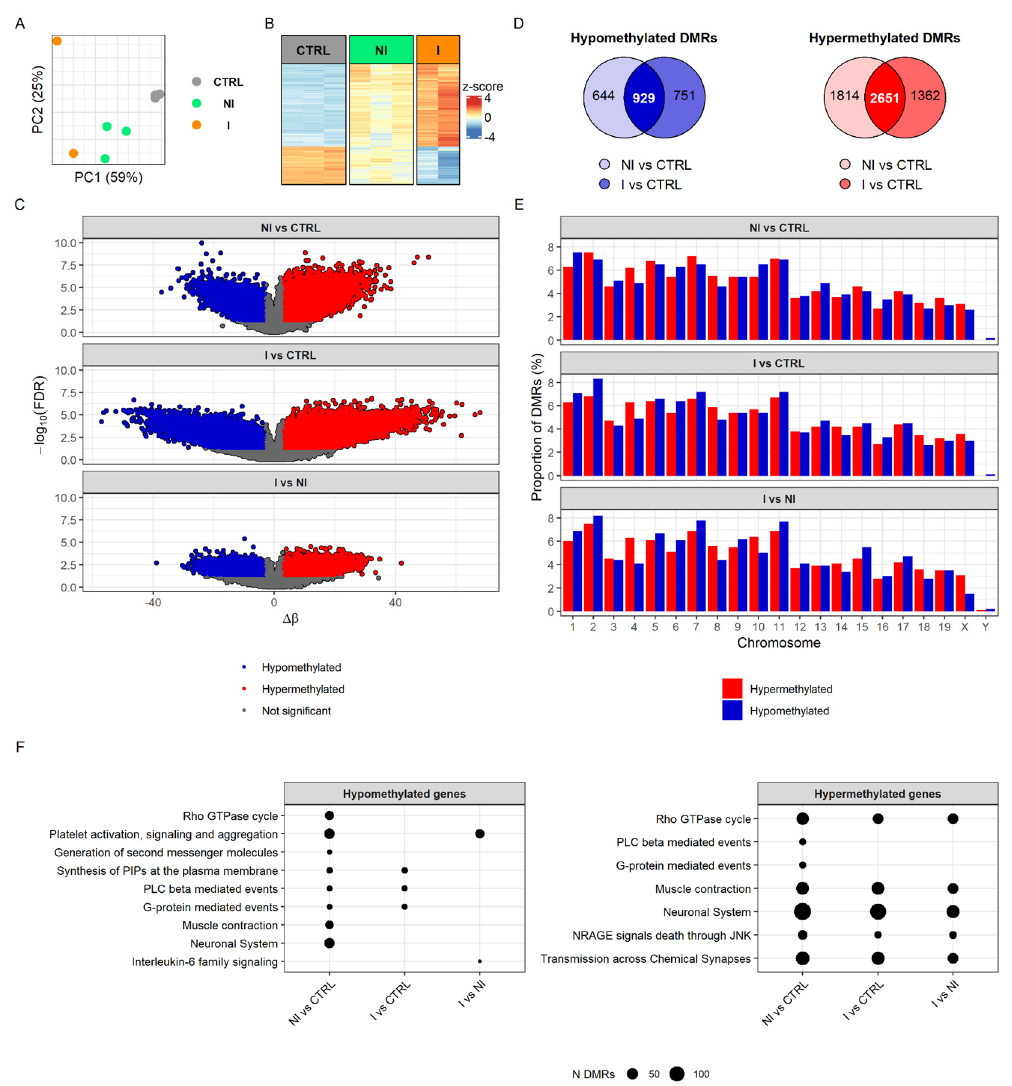
Figure 2. DNA methylation analysis of mouse bladder cancers by Infinium™ Mouse Methylation BeadChip. ( A ) Principal components analysis (PCA) score plot of the full methylome. ( B ) Heatmap showing overlapping of significant differentially methylated probes (DMPs) of the three different comparisons (NI vs. CTRL, I vs. CTRL and I vs. NI; n DMPs = 6291) with the cut off |delta beta values| > 0.25. ( C ) Volcano plots summarizing methylome analysis of a different distribution of hyper- and hypomethylated DMPs expressed with delta β and p -value in each comparison. ( D ) Venn diagrams of the overlap of hyper- and hypomethylated differentially methylated regions (DMRs) identified in non-invasive and invasive groups relative to controls with applied cut off |mean methylation difference| > 3. ( E ) The proportion of DMRs distributed along the chromosomes. ( F ) Top Reactome pathways enriched in hypo- or hypermethylated DMRs in each comparison. I, invasive; NI, non-invasive; CTRL, control.